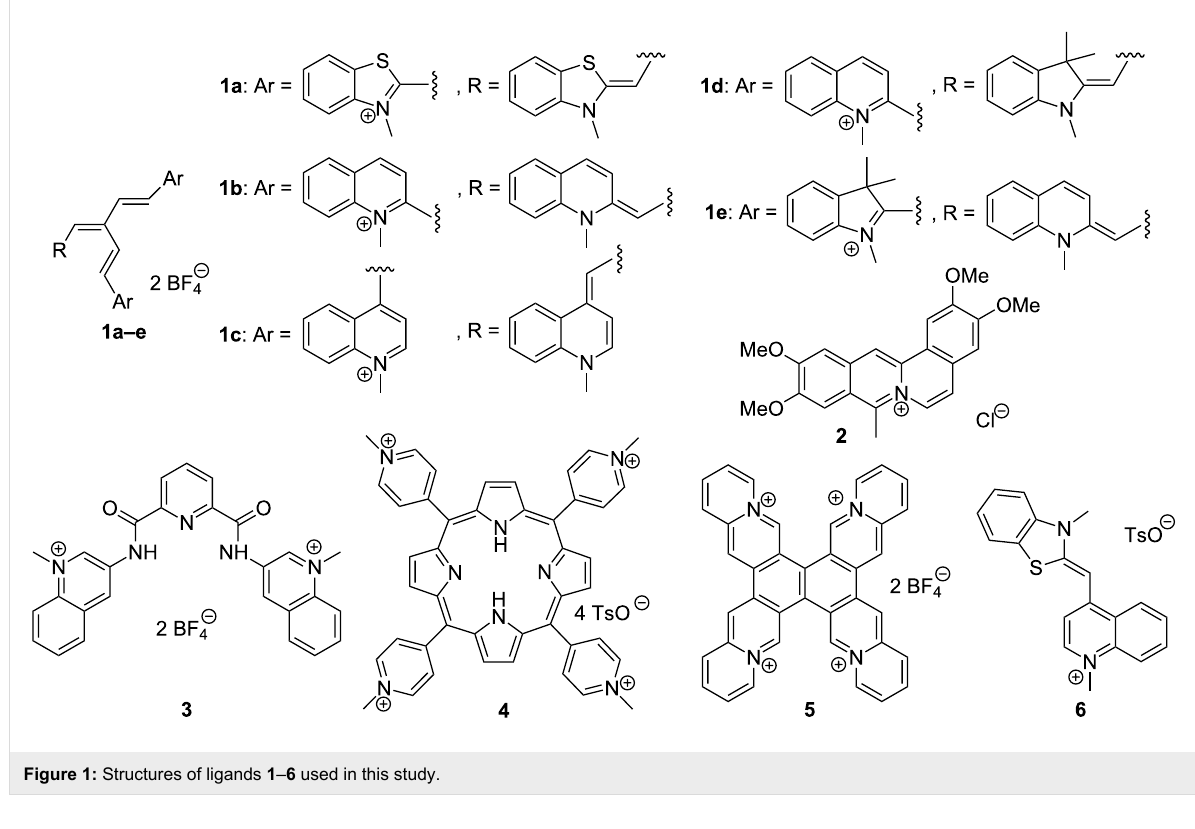
Figure 1: Structures of ligands 1 – 6 used in this study.